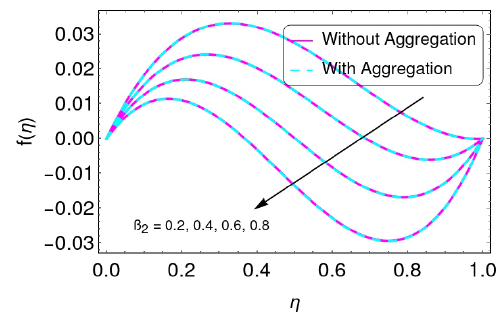
Figure 6. The results of ß 2 on f ( η ) .